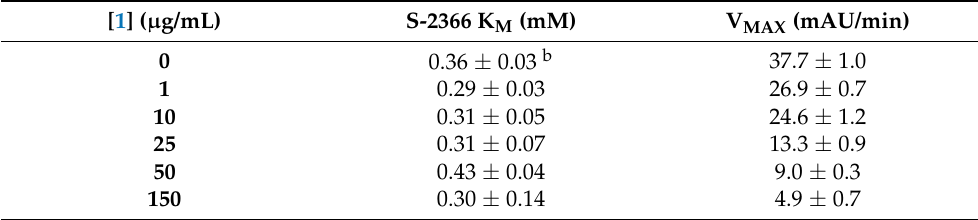
a K M and V MAX values of S-2366 chromogenic tripeptide substrate hydrolysis by human FXIa were spectrophoto- metrically determined by Michaelis–Menten kinetics. b Error represents ± 1